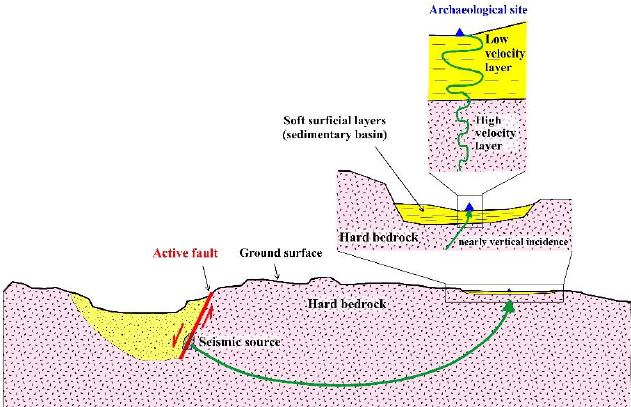
Figure 1. (Lower panel) Refraction processes that produce steep incidence of a seismic wave near the ground surface. (Middle and Upper panels) Zoomed areas where seismic wave amplification occurs due to the transition from higher velocity rock (higher impedance) to lower velocity sediments (lower impedance). Modified with permission from [18]. Copyright 2016, Hinojosa-Prieto, H.R.